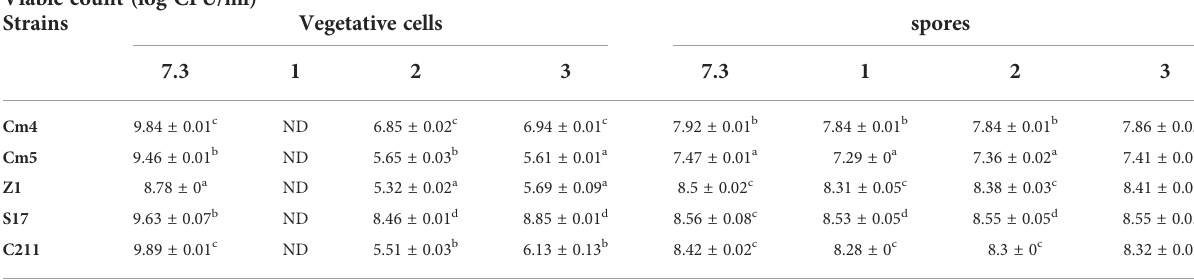
*Bacterial levels were determined by plate count on TSB. Data are presented as (mean ± SD, n = 3) with different superscript letters denoting a signi fi cant difference (p< 0.05). ND, not